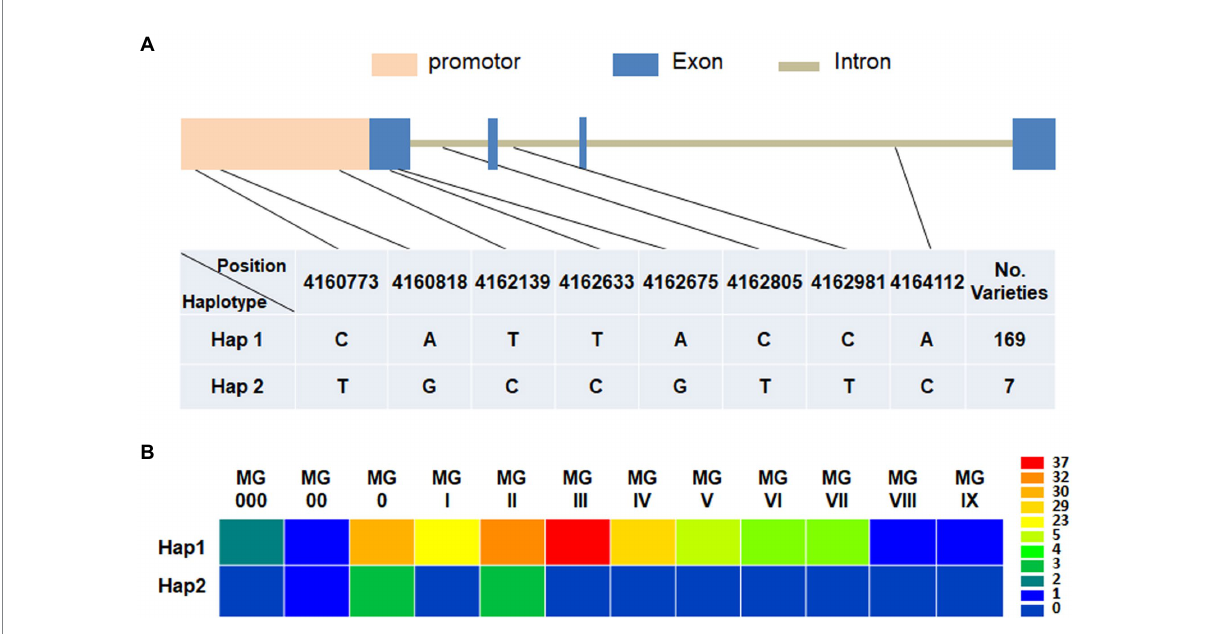
FIGURE 7 Haplotype identification (A) and corresponding maturity groups (B) of GmFT3a in 176 representative soybean